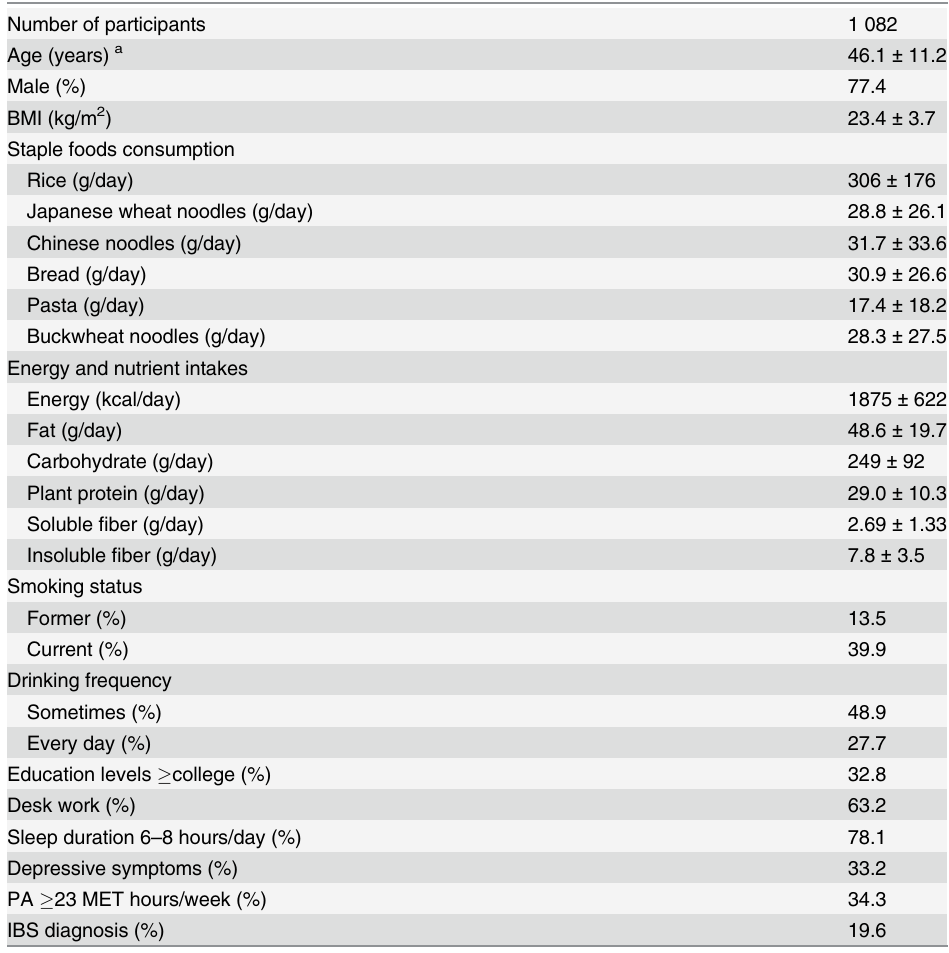
Table 1. Participant